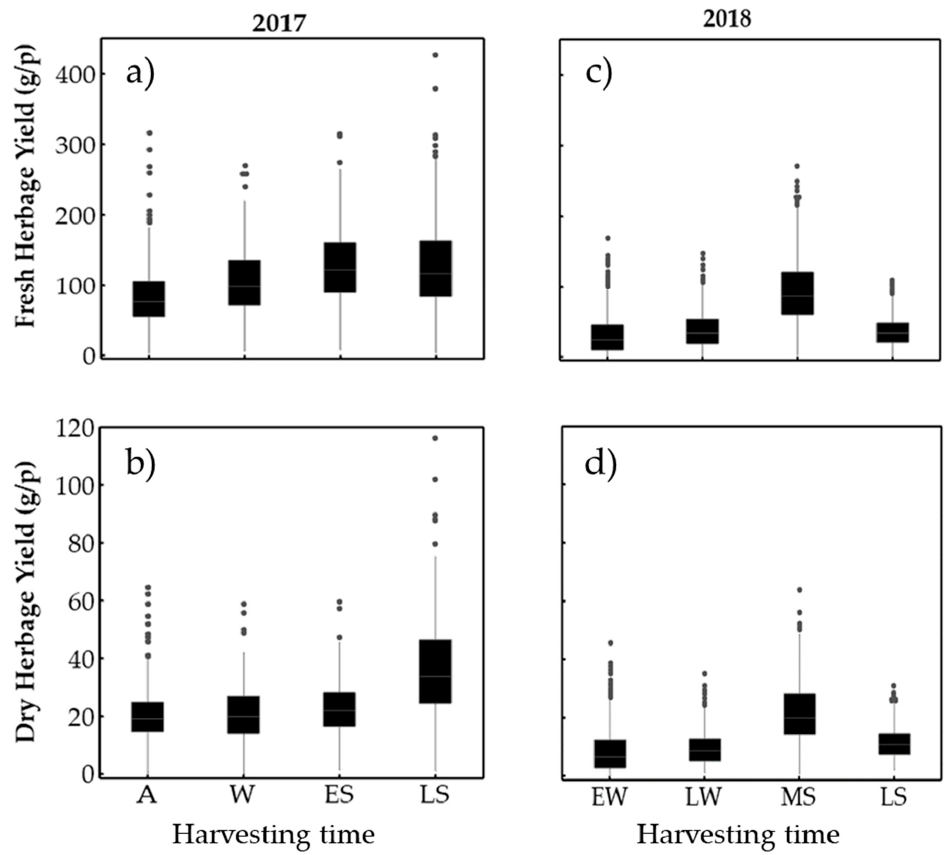
Figure 4. Measured fresh herbage yield at four seasons of the year 2017 and 2018 ( a , c ) and dry